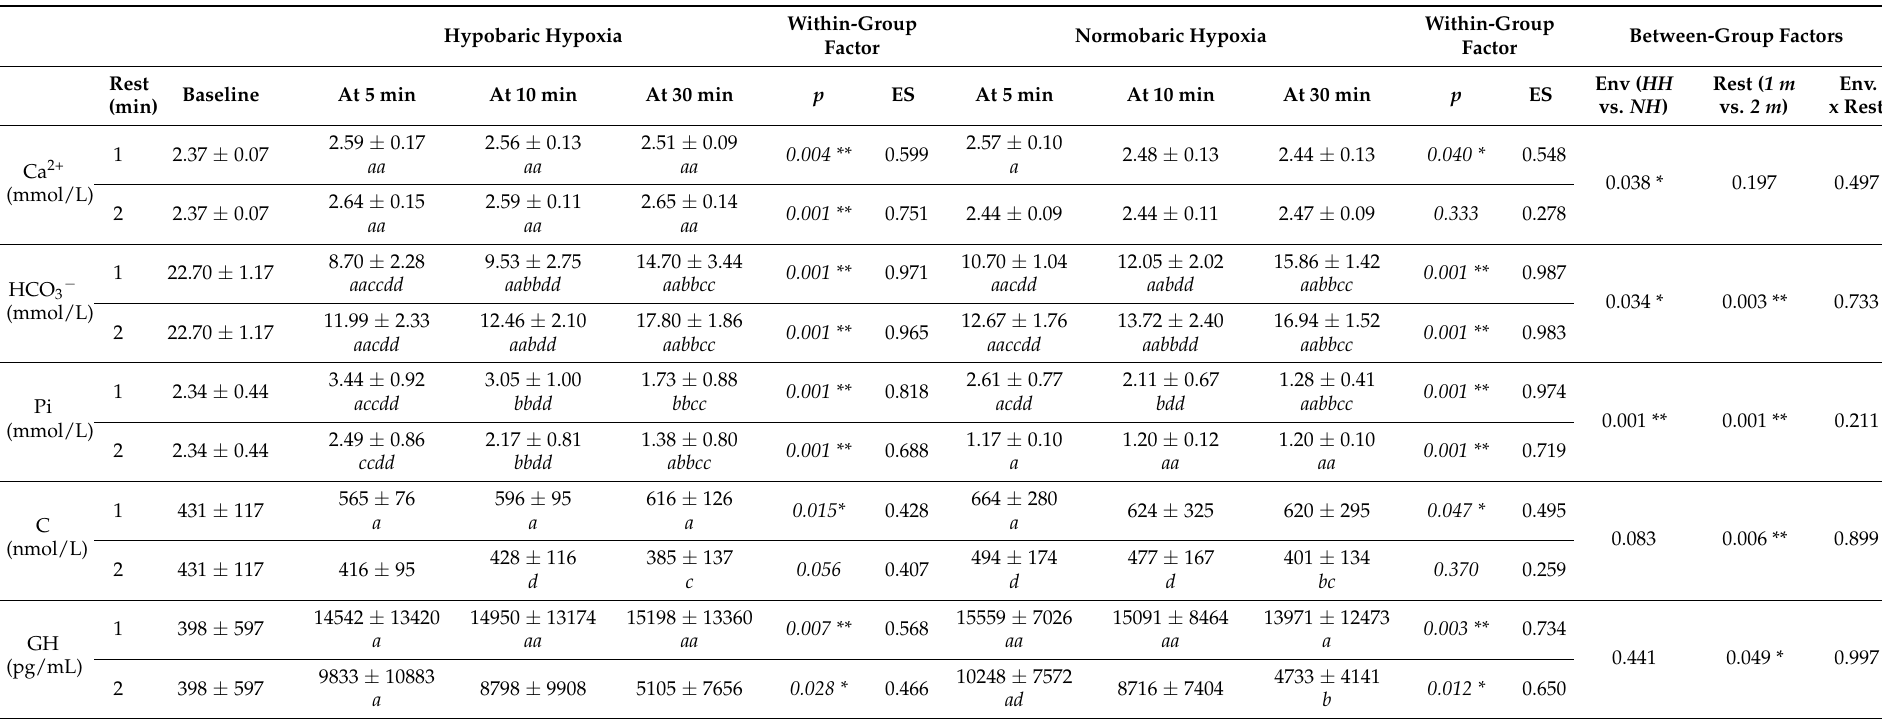
Table 2. Ca 2+ , HCO 3 − , Pi, and hormones after resistance training session in hypobaric and normobaric hypoxia. Hypobaric Hypoxia